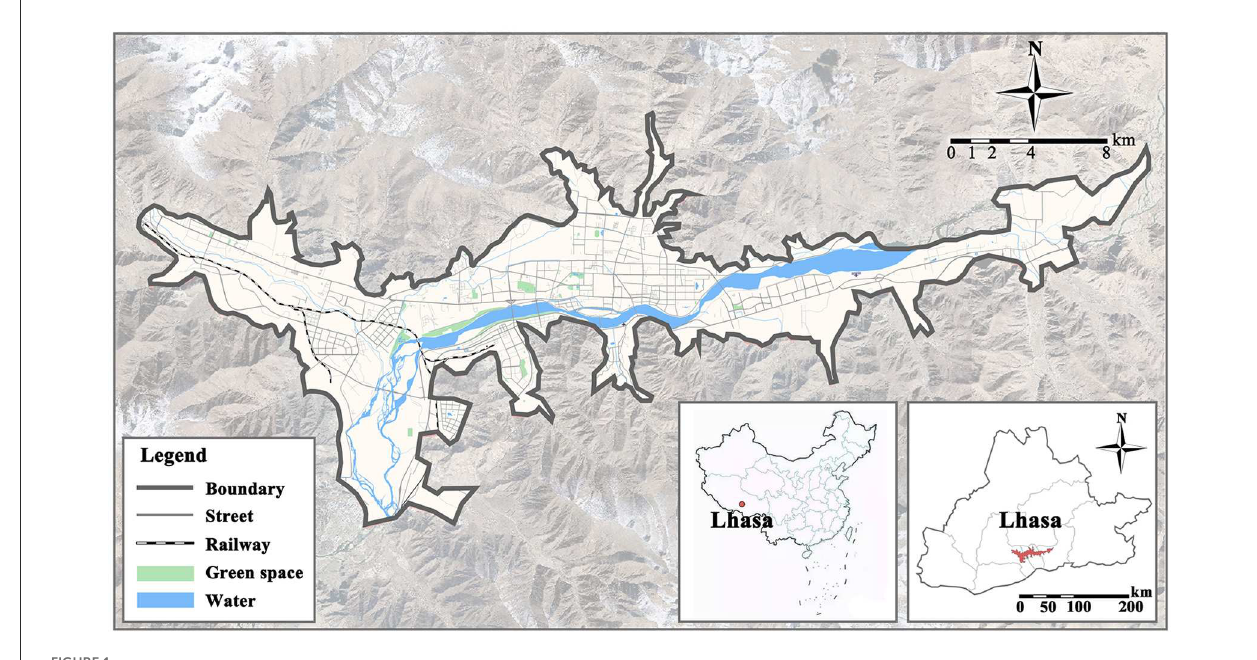
FIGURE1 Map of the Lhasa study